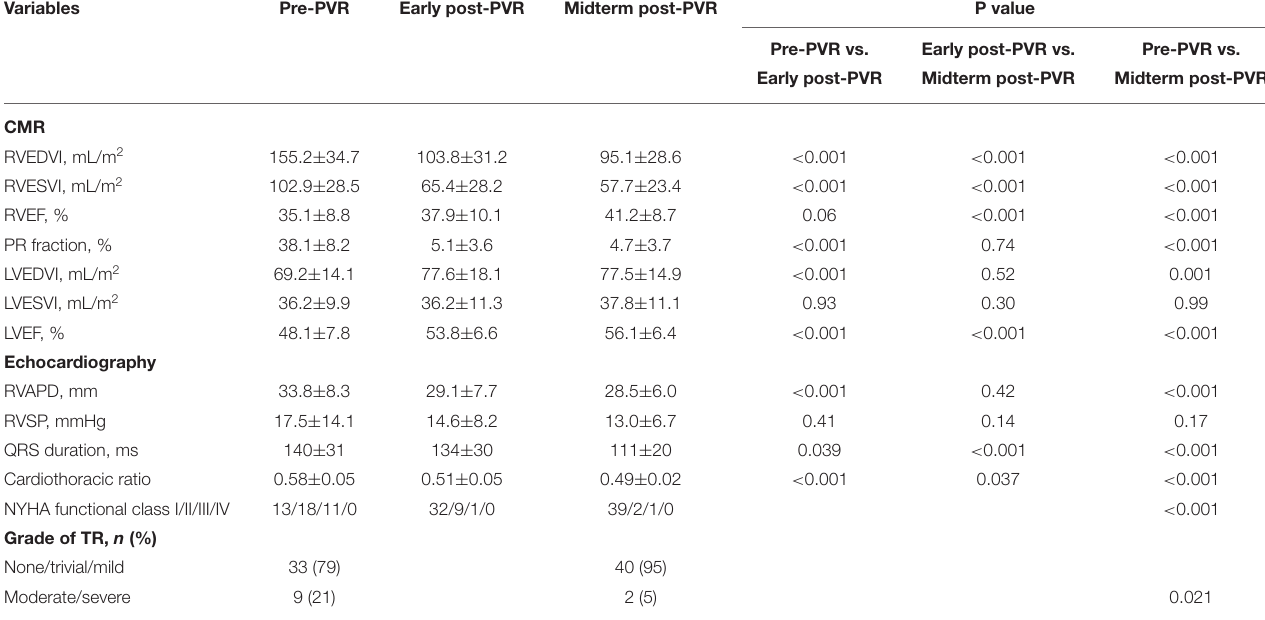
TABLE 3 | Pre-PVR, early post-PVR, and midterm post-PVR variables of patients with rTOF. Variables